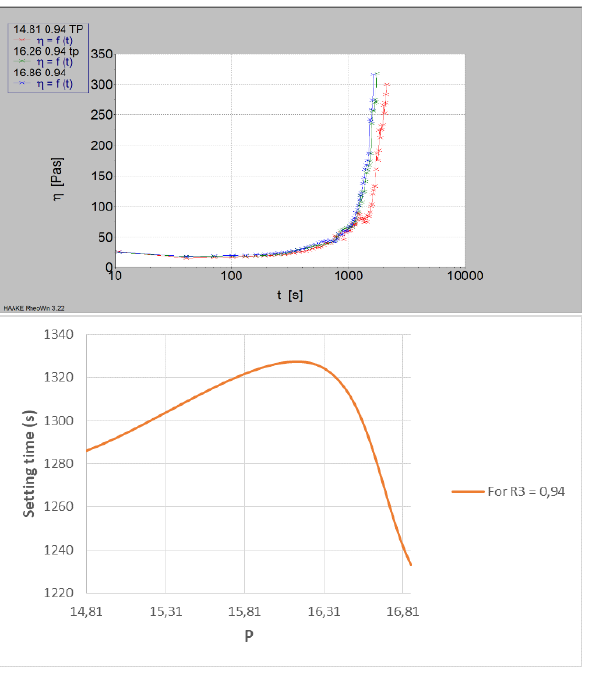
Figure 14: Evolution of the setting time for a different P and for L/S = 0.94